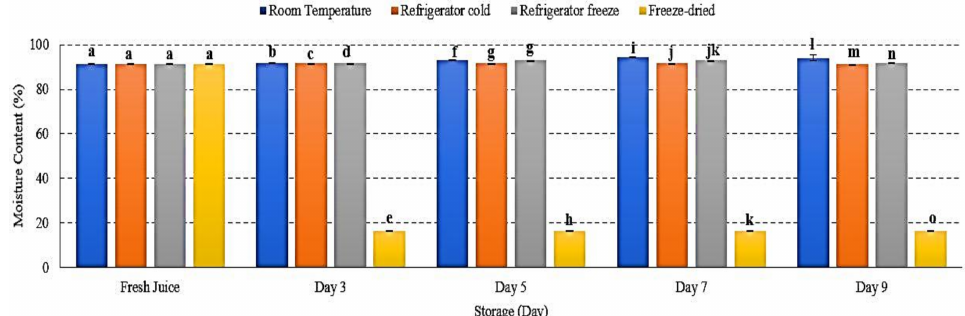
Figure 4. The moisture content of watermelon juice during 9 days of storage. Different letters indicate significant differences between samples p < 0.01.